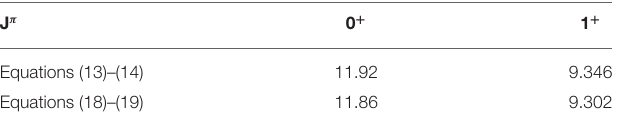
TABLE 1 | Parameters of the local N2LO 3BF employed in this work. TABLE 2 | Comparison of the p- 3 He singlet (J π = 0) and triplet (J π = 1) scattering lengths calculated by the approach of Equations (13)–(14) to those obtained by solving Equations